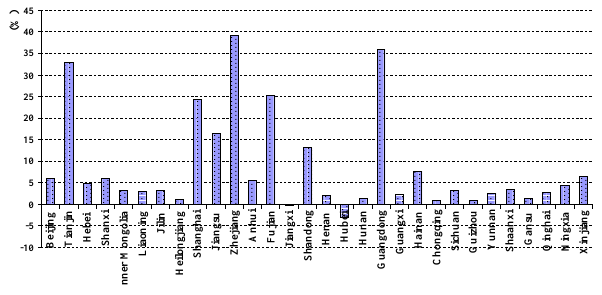
Figure 3. Ratios of net virtual water export to water use for final demand in individual provinces (2002) Fig. 3. Ratios of net virtual water export to water use for final de- mand in individual provinces (2002).